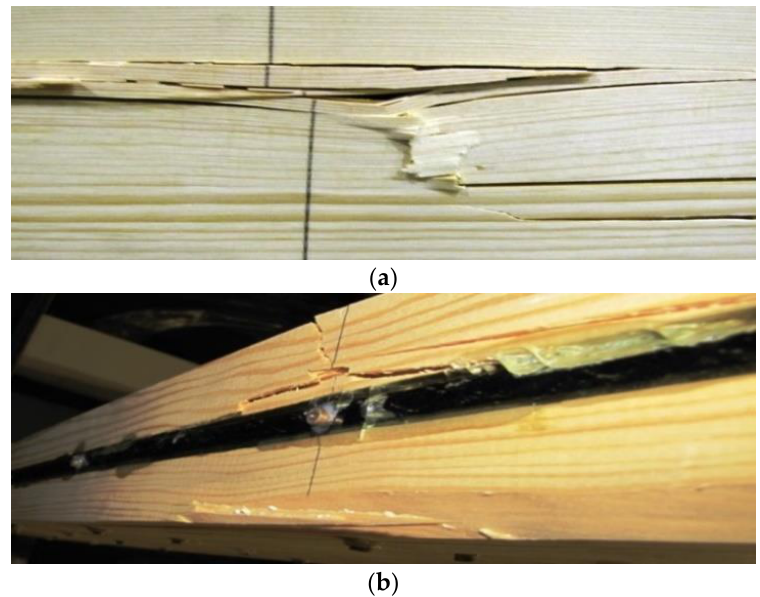
Figure 5. Failure damage images in glued laminated beams strengthened in the tension and com- pression zones—S2: ( a ) compression zone shear (60 kN); ( b ) wood and epoxy glue detachment in tension zone.